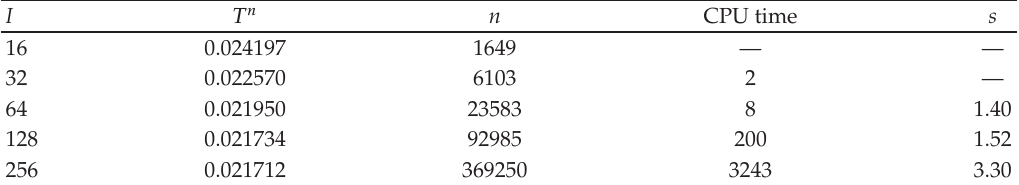
Table 5: Numerical blow-up times, numbers of iterations, CPU times (cid:3) seconds (cid:4) and orders of the approximations obtained with the explicit Euler method defined in (cid:3) 10.1 (cid:4) .